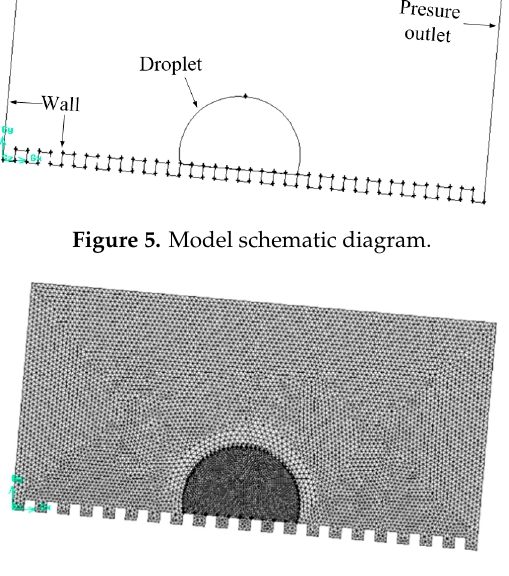
Figure 6. Grid diagram. Figure 6. Grid